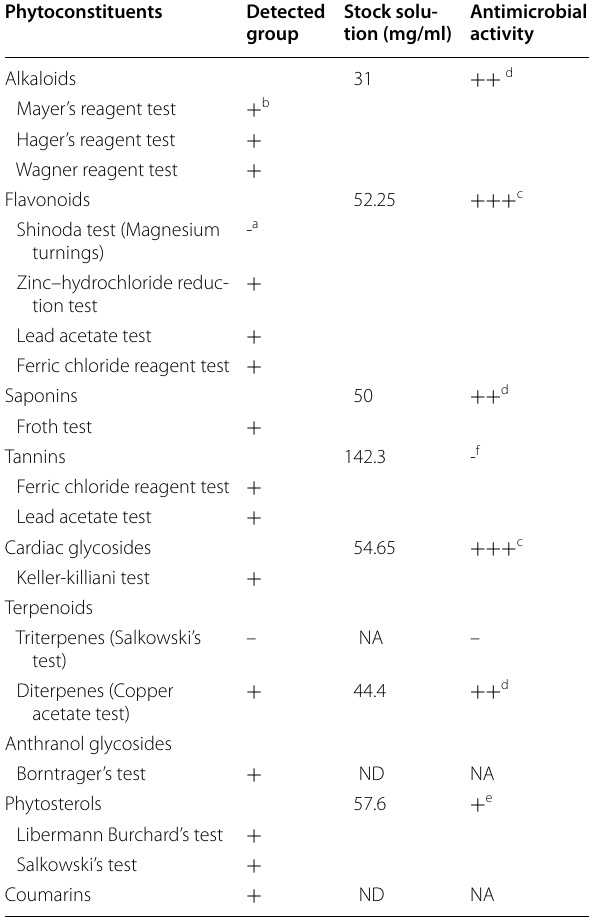
Table 2 Qualitative detection and antimicrobial activity of Gymnema sylvestre